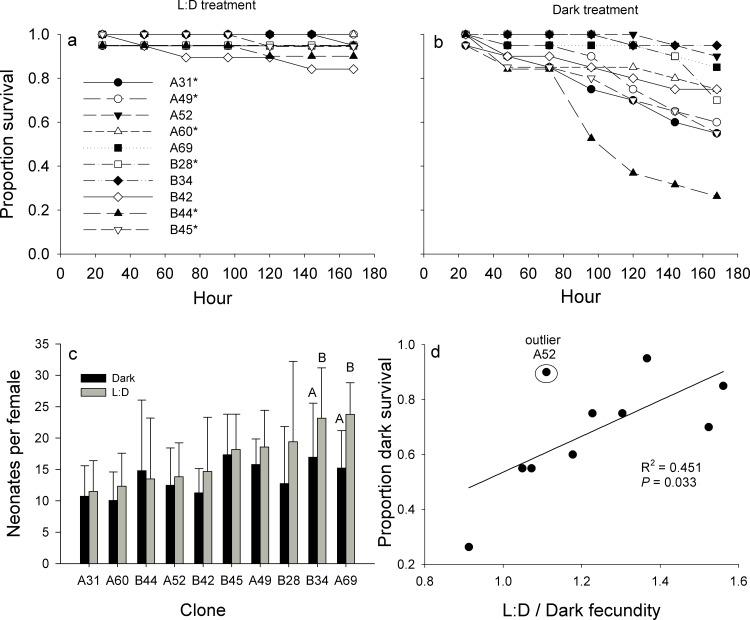
Dark tolerance fitness.Survival through time for ten clones in the a) L:D treatment and b) dark treatment. c) Mean cumulative number of neonates produced by surviving Daphnia in the dark and diel treatments. Capital letters indicate statistically significant differences between treatments for a given clone. d) Relationship between proportion survival in the dark treatment and proportional difference in fecundity between treatments (L:D / dark fecundity). Each data point represents a clone. A value of 1 on the Y-axis represents equal fecundity between diel and dark treatments. Circled point was identified as an outlier (SYSTAT 12). Clone line variability over time should be noted, specifically looking at >80 hours (b) and that clones with the lowest survival at 160+ hours (b) are typically associated with differences in diel and dark tolerances (c) over the course of the experiments.